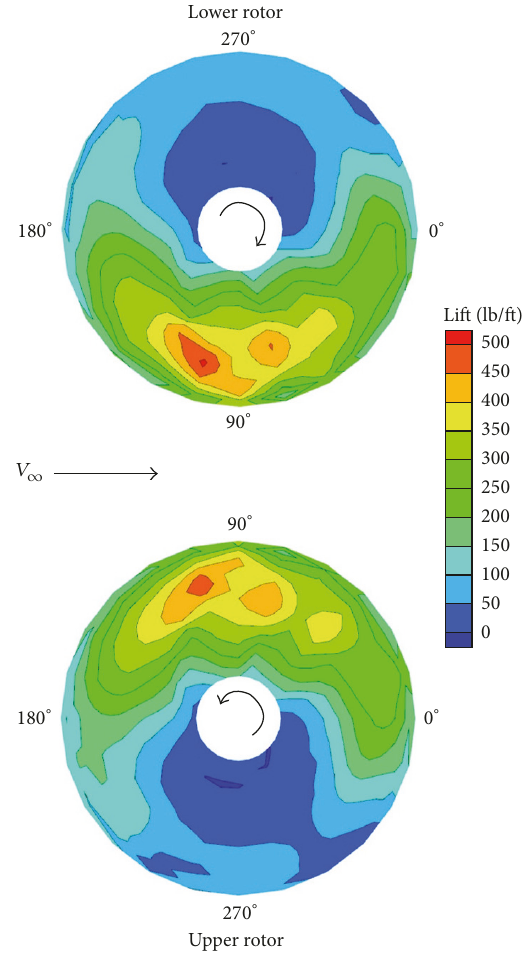
Figure 16: Lift distributions at 140 knots in compound helicopter mode (LOS =